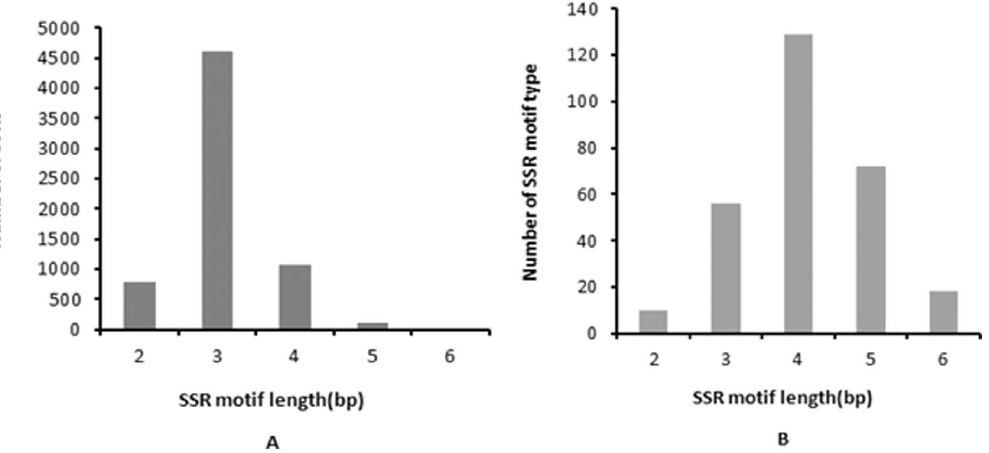
Figure 4. Distribution of SSR motif. ( A ) Distribution between SSR motif and number of SSRs. ( B ) Distribution between SSR motif and number of SSR motif